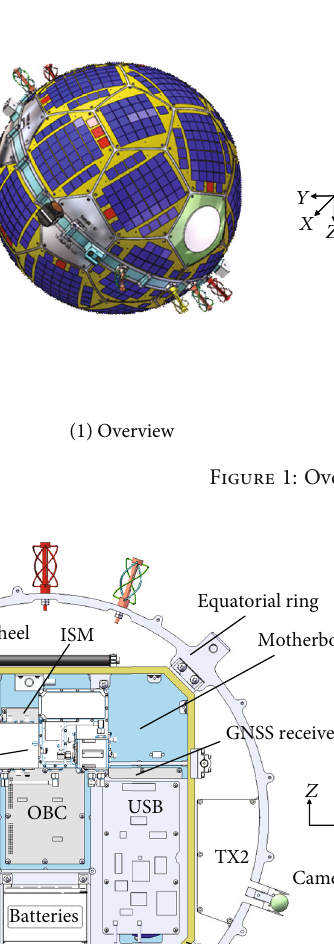
Figure 4: Overview of Q-SAT thermal